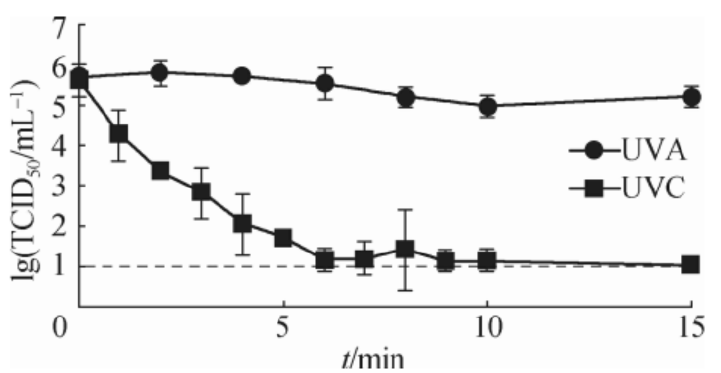
Figure 8. Effect of UV radiation on the infectivity of SARS-CoV [94].